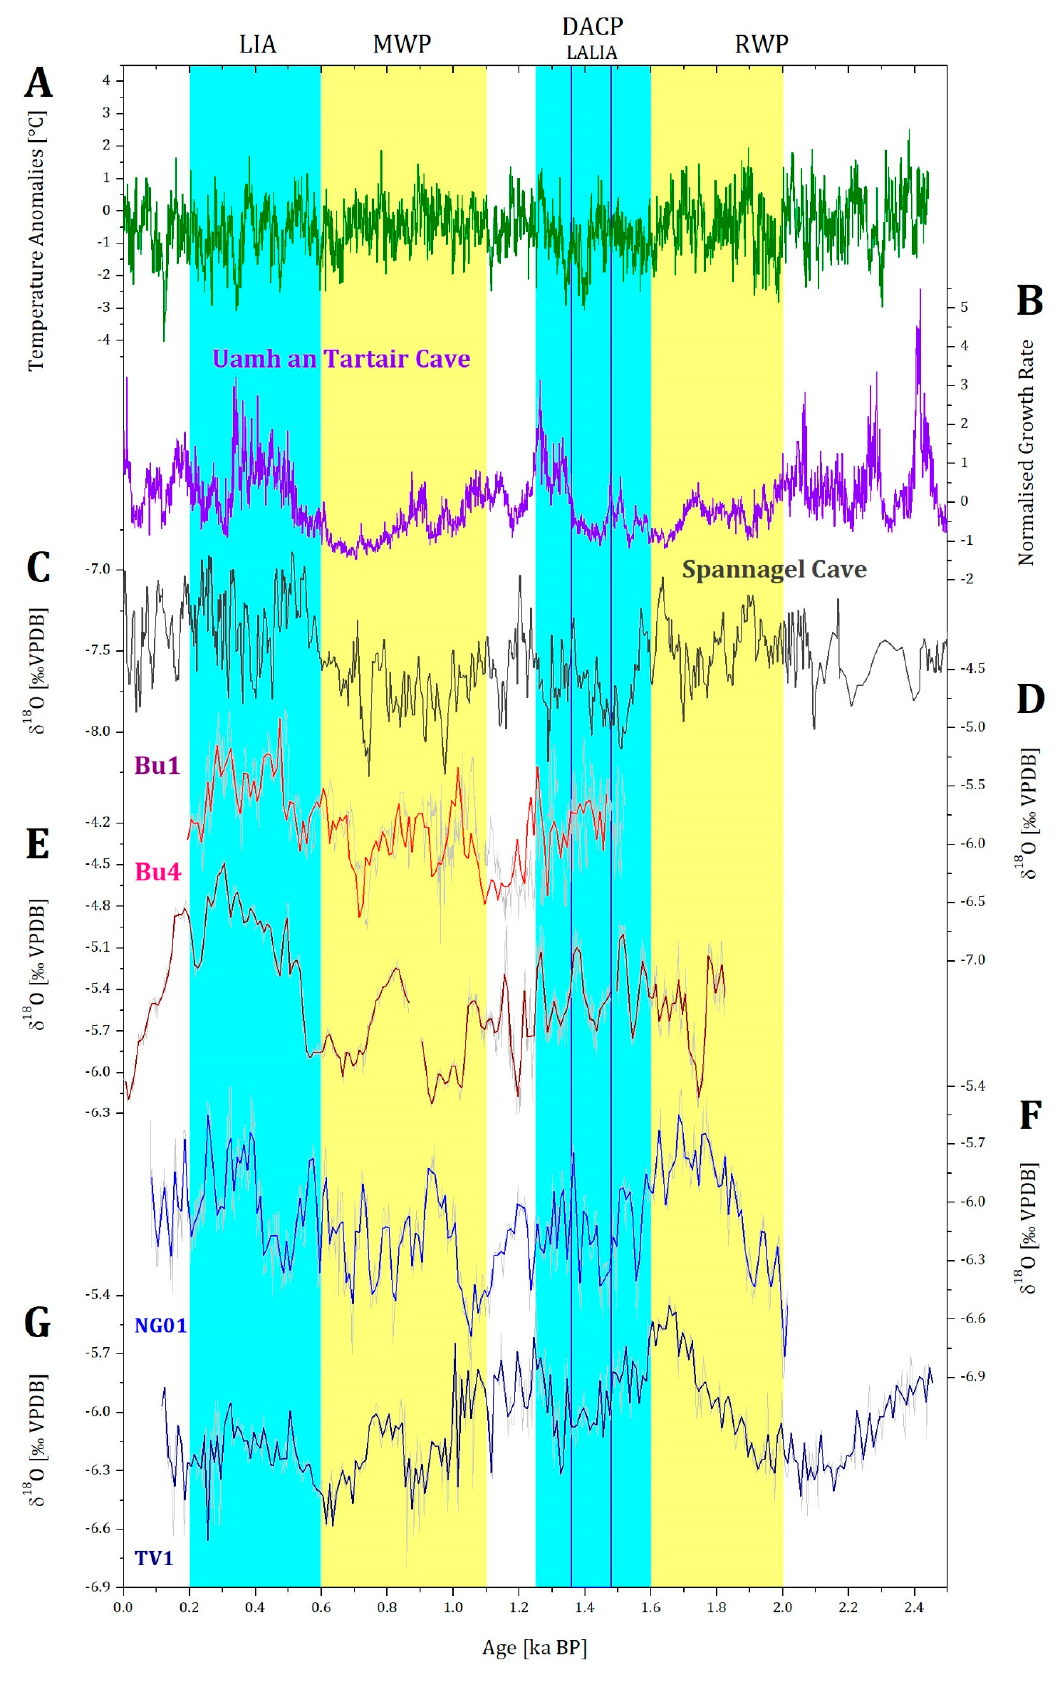
Figure 11. δ 18 O records of all speleothems (Bu1, Bu4, NG01 and TV1) in comparison with other climate records. ( A )